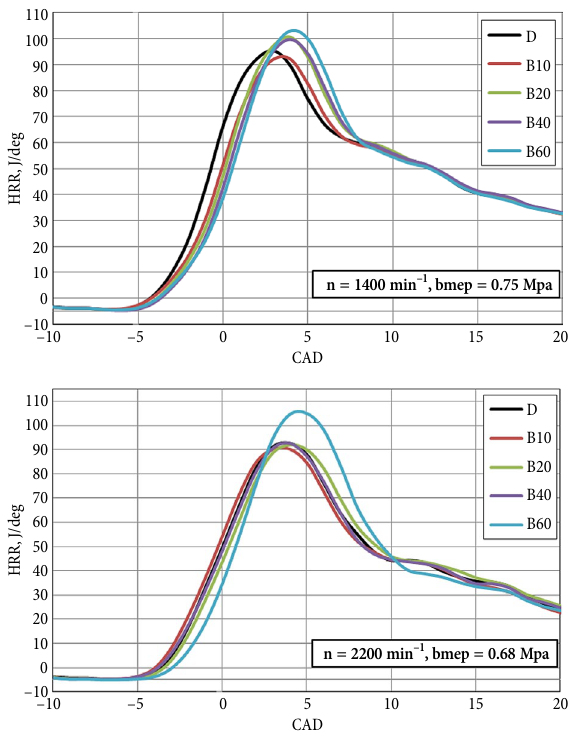
Fig. 5. Dependence maximum cylinder pressure gradient (( dp / dφ ) max ) on engine load ( bmep )